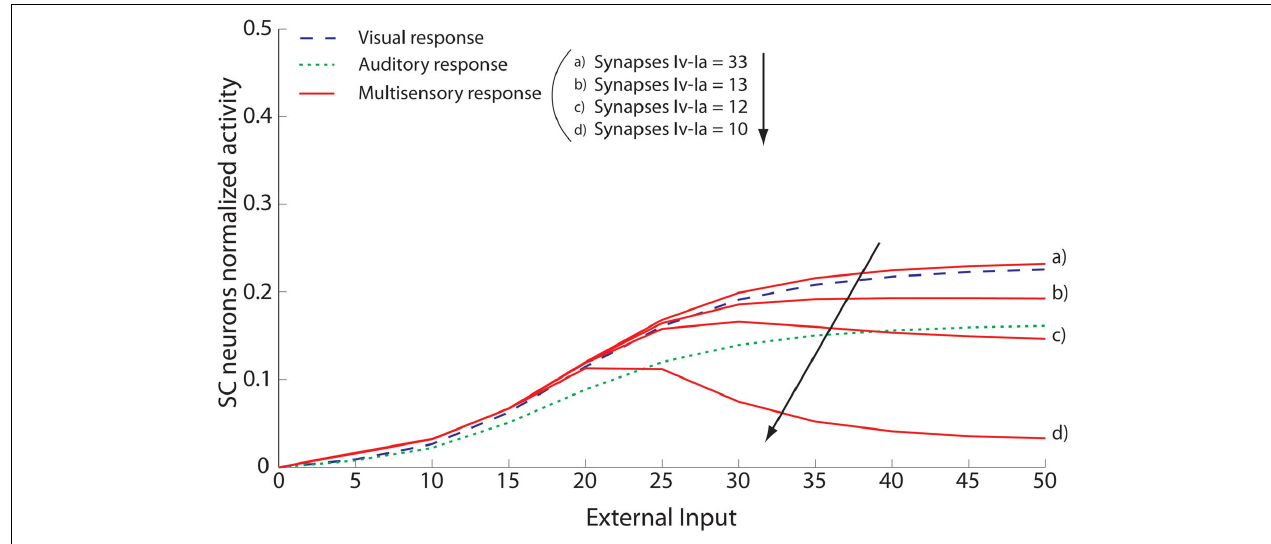
FIGURE 5 | Sensitivity analysis of the strength of inhibitory competition in the ascending path. The fi gure shows the activity of SC neurons (continuous lines) in response to different cross-modal inputs during total AES deactivation (the same case as in Figure 4B) and assuming a different strength for the inhibitory synapses between the interneurons in the ascending path (i.e., parameters K Eqs 11 and 12) . The responses to unimodal (auditory or visual) stimulation are also